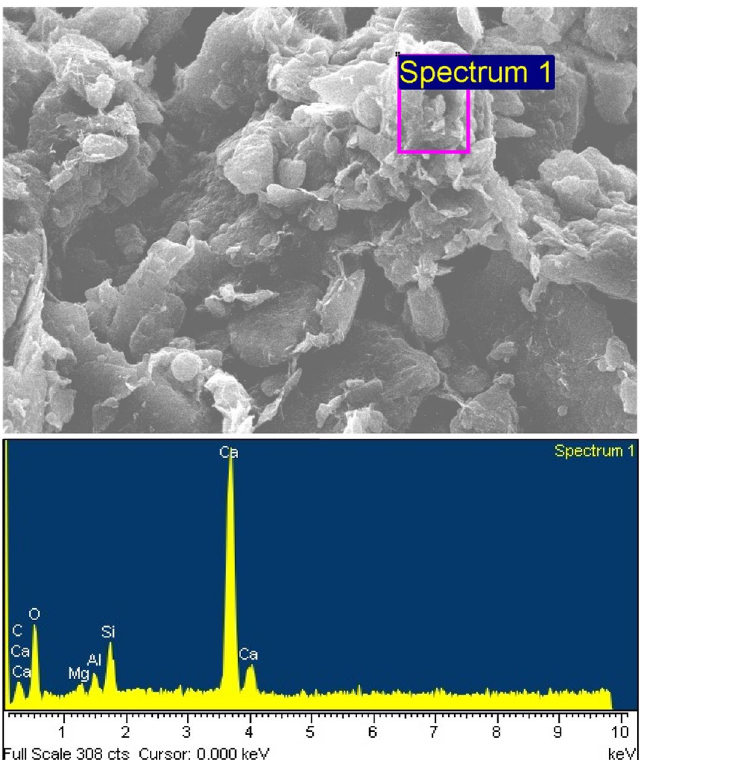
Figure 8. EDS graph of the VA 10 D 90 -S pozzolanic